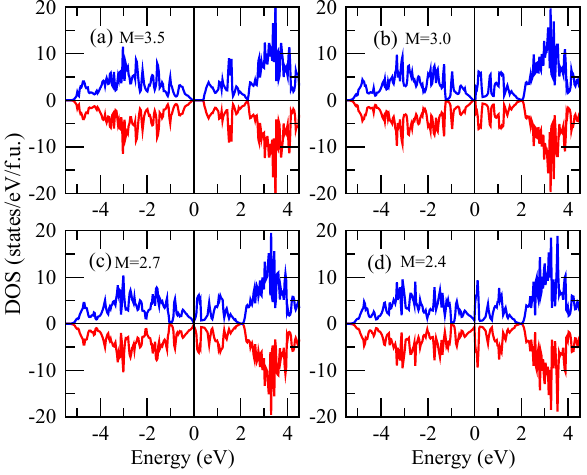
Figure 5. Calculated density of states of ThMnAsN with the C-AFM spin configuration for fixed Mn moments of ( a ) M = 3.5 µ B , ( b ) M = 3.0 µ B , ( c ) M = 2.7 µ B , and ( d ) M = 2.4 µ B . Up-spin and down-spin density of states are indicated by blue and red lines, respectively. The Fermi level is denoted by a vertical black line at E = 0 eV.